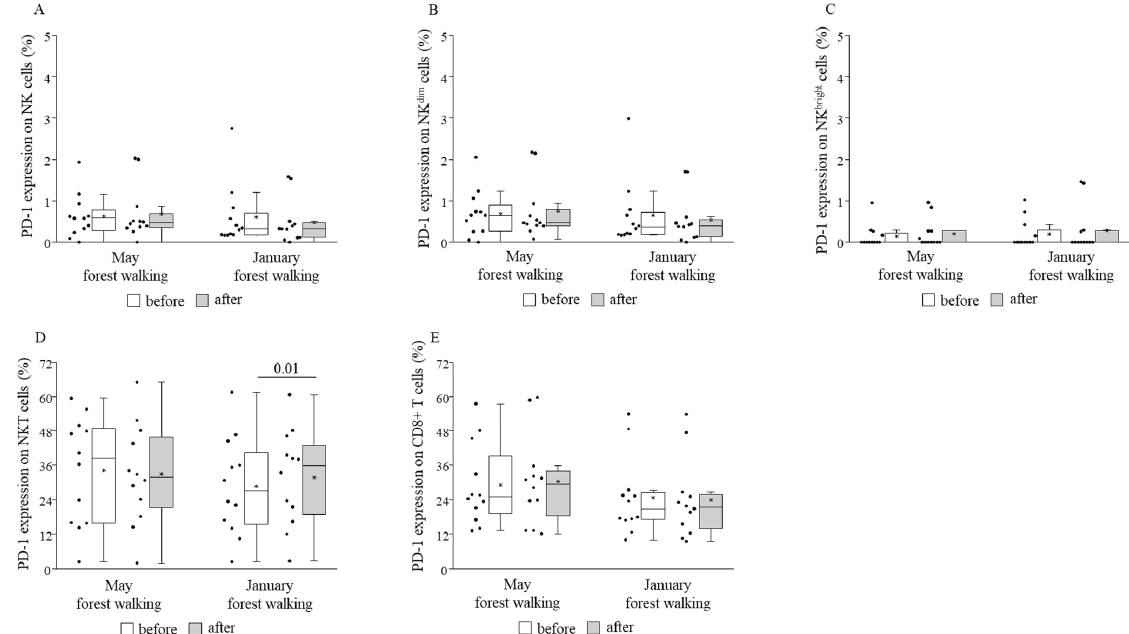
Figure 9. PD-1 expressions on total NK ( A ), NK dim ( B ), NK bright ( C ), NKT ( D ), and CD8+ T ( E ) cells prior to and following the late spring (May) and winter (January) forest walks. The middle line within the box represents the median, the middle dot within the box represents the mean, the boxes indicate the interquartile ranges between the 25th and 75th percentiles, and the whiskers show the most extreme observations in the box plot. Individual dots left from the boxes represent individual data values. Differences were considered statistically significant for p -values < 0.05. Statistically significant p -values are indicated on the horizontal lines outside the boxes.